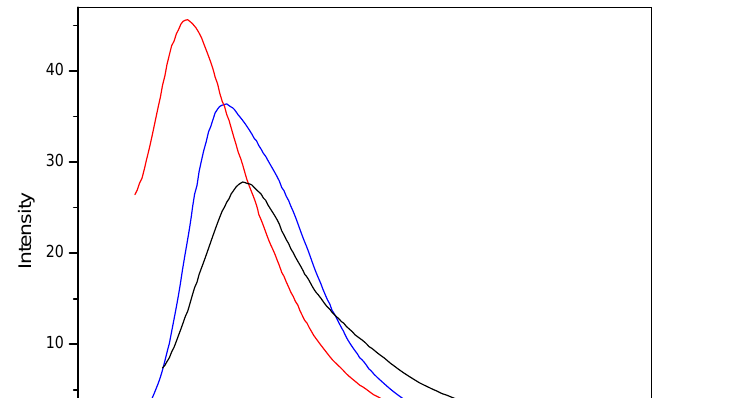
= 490 nm ⎯⎯ ) and of 4d in ex = 430 nm ⎯⎯ ). ex